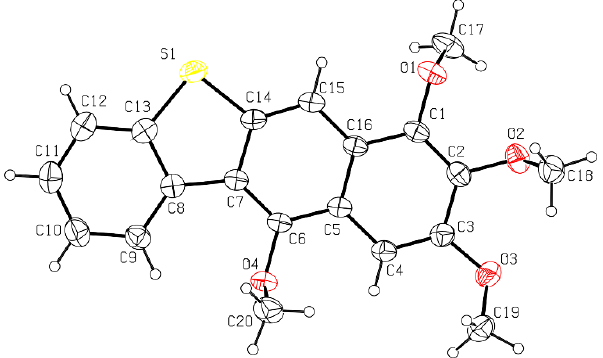
Figure 1. A view of molecule 13, showing the atom numbering scheme and displacement ellipsoids drawn at the 30% probability level. H atoms are shown as small spheres of arbitrary radii.